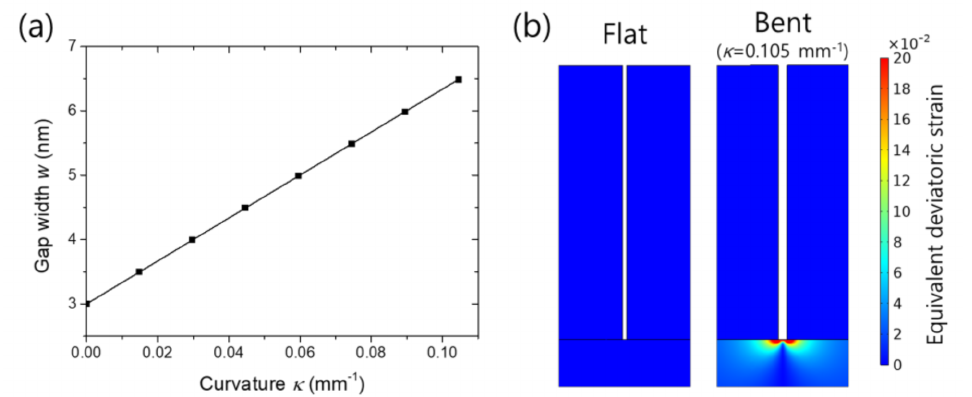
Figure 2. Nanogap slit deformation during bending: ( a ) Gap width versus substrate curvature with a linear fit (solid line); ( b ) Distributions of equivalent deviatoric strain in the vicinity of a slit for the flat and bent ( κ = 0.105 mm − 1 )